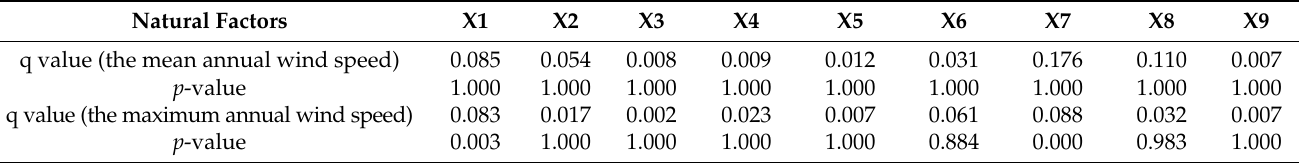
Table 4. Analyzing results by the geographic factor tool.